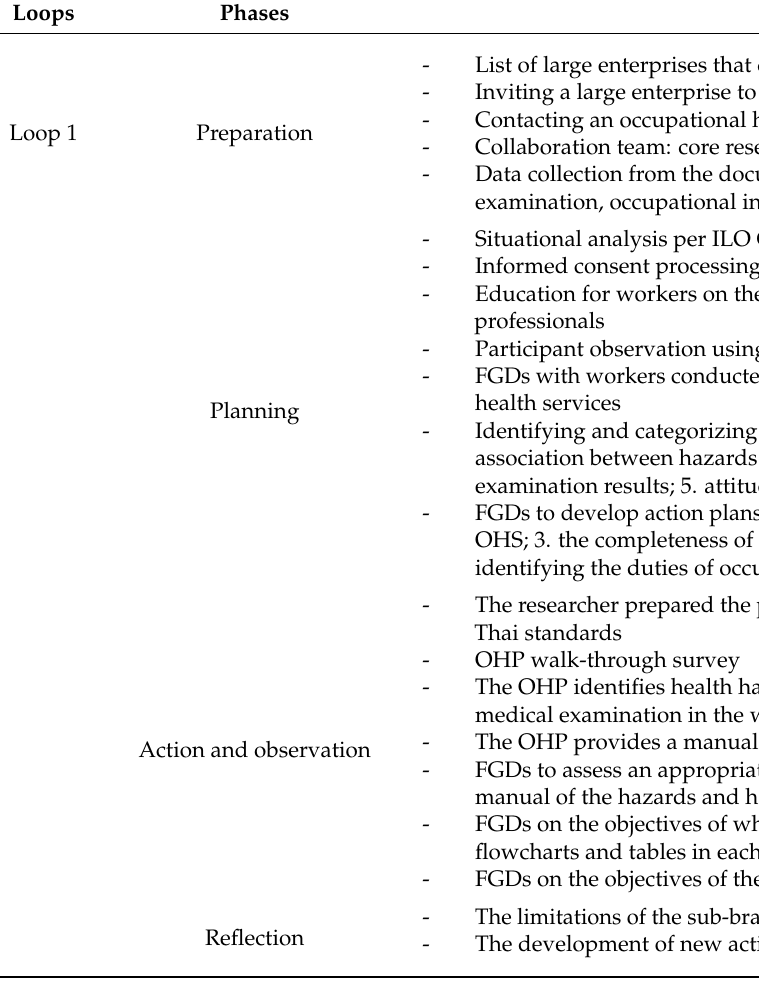
Table 5. Summary of this study’s loops, stages, activities, and session plans.